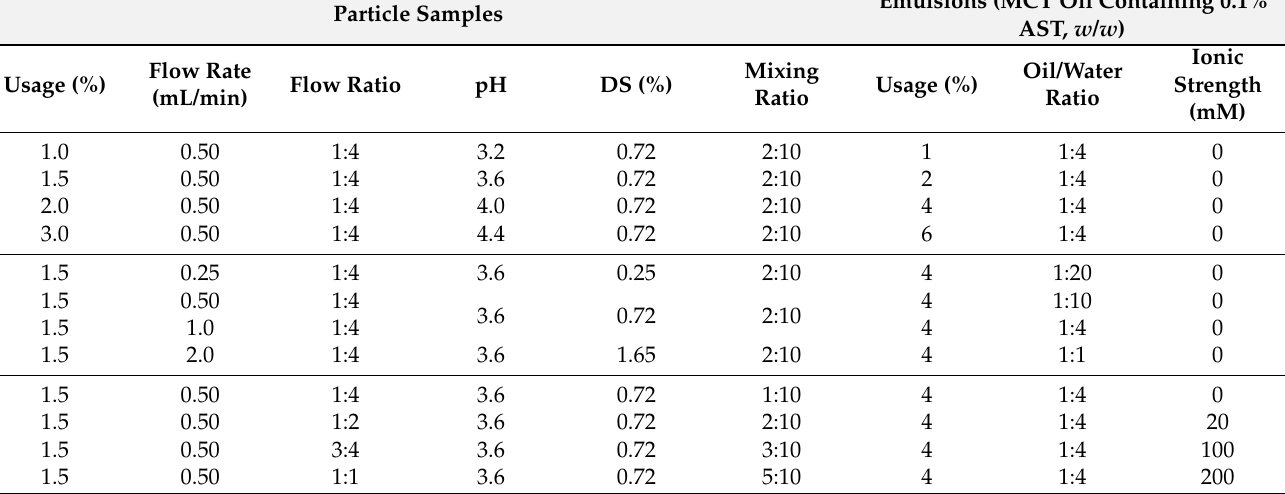
Table 1. The detailed information regarding the reaction conditions and composition of all prepared OS/ β -lg complex particles and the corresponding